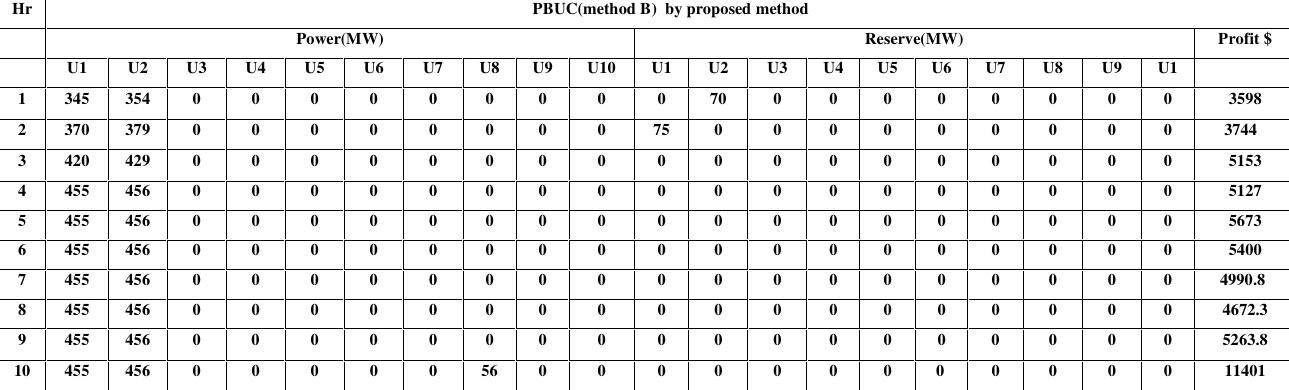
Table X Example of power and Reserve generation of reserve payment method B (10 Units